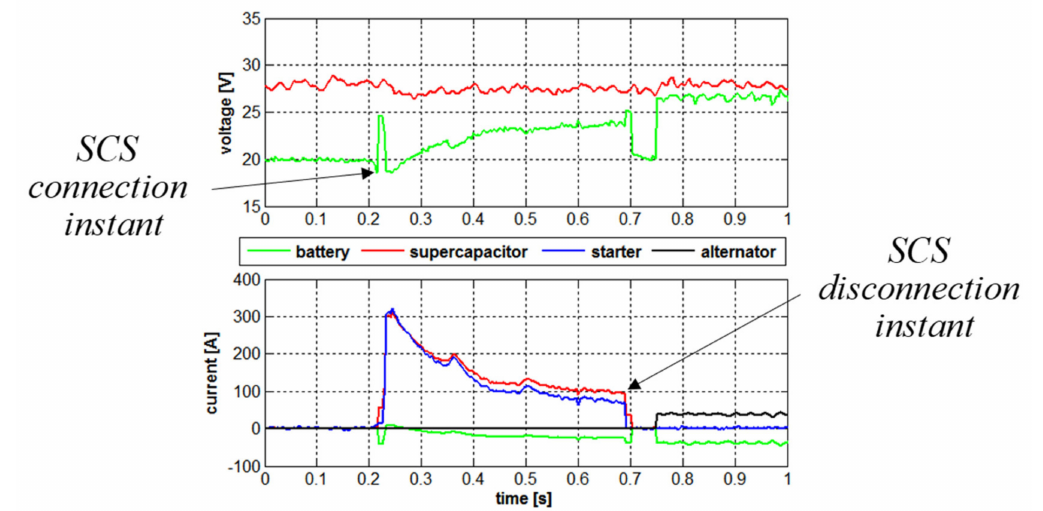
Figure 9. Experimental results—SCS connection and disconnection